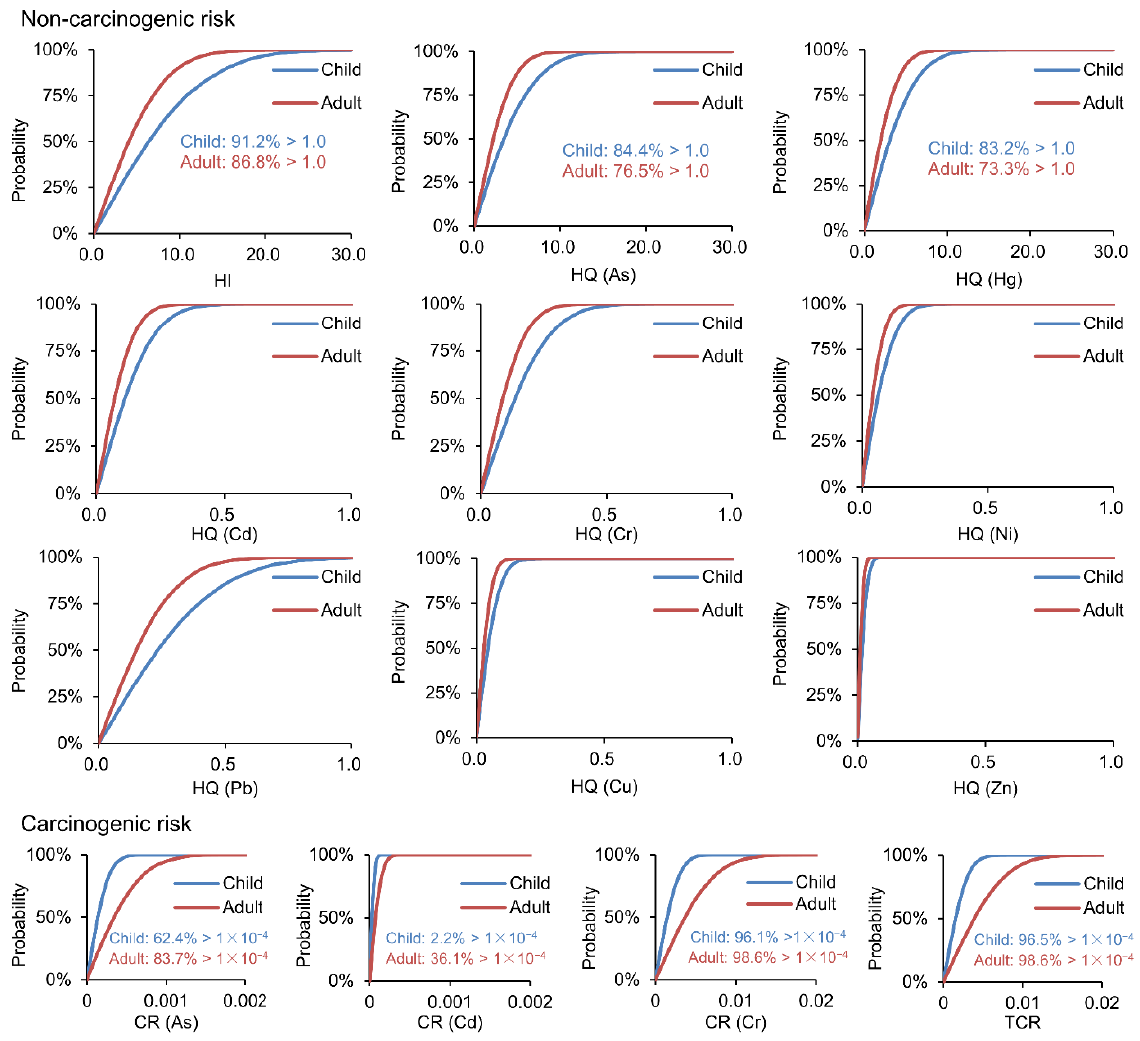
Figure 7. Cumulative probability of non-carcinogenic and carcinogenic risks.